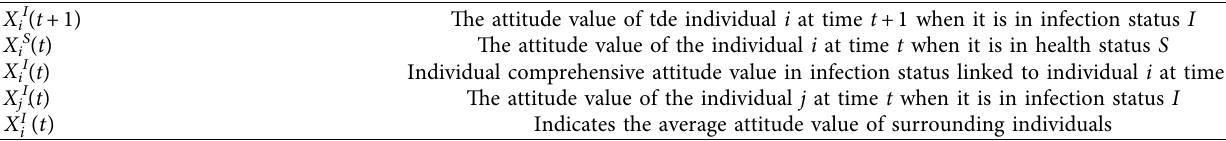
Table 1: Description of dynamic variables.